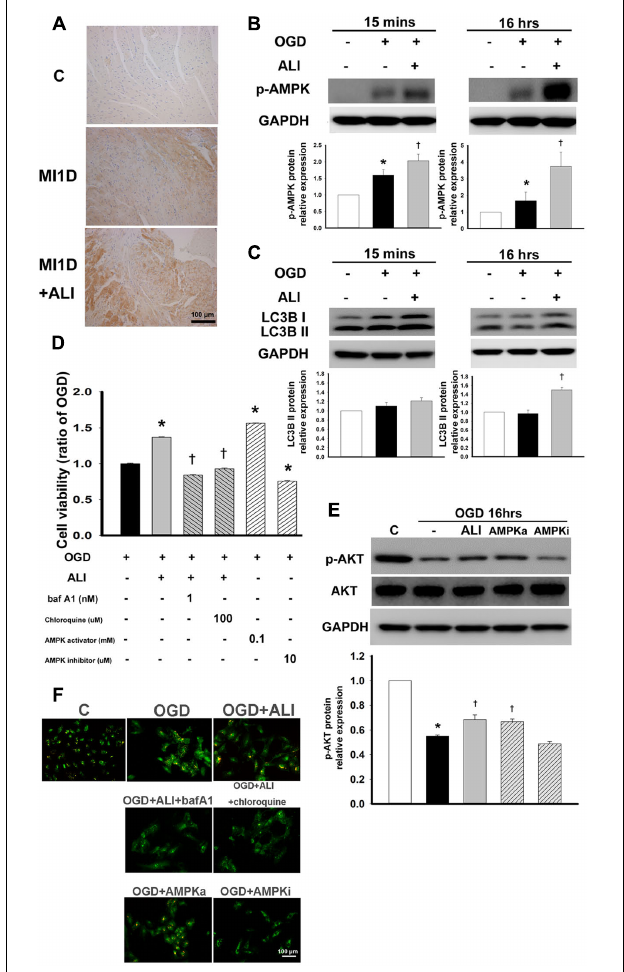
FIGURE 6 | Aliskiren increases autophagy-induced cell viability by activation of the AMPK pathway in OGD-treated H9c2 cells. (A) Representative images of the effect of aliskiren on AMPK expression in cardiac tissues at 1 day after MI by immunohistochemistry. Bar: 100 µ m. (B,C) H9c2 cells were treated with 20 µ M aliskiren after OGD 15 min or 16 h, and then AMPK phophorylation and LC3BII expression were detected by Western blotting. (D) Cardiomyocytes co-treated with 20 µ M aliskiren with or without bafilomycin A1 or chloroquine (autophagy inhibitors), or AICAR (an AMPK activator), or dorsomorphin (an AMPK inhibitor), were exposed to OGD for 16 h, and then cell viability was examined by the MTT assay. ∗ P < 0.05 compared with OGD. † P < 0.05 compared with OGD + ALI. (E) Cardiomyocytes treated with 20 µ M aliskiren, AICAR or dorsomorphin were exposed to OGD for 16 h, and then p-AKT and total AKT were examined by Western blotting. p-AKT was normalized to total AKT. (F) Autophagosomes were examined by acridine orange staining. Bar: 100 µ m. Each of the experiments was repeated three times. The data are means ± SEM. GAPDH was used as the internal control. ∗ P < 0.05 compared with the control. † P < 0.05 compared with OGD. Based on the above findings, aliskiren has improved the surrogate